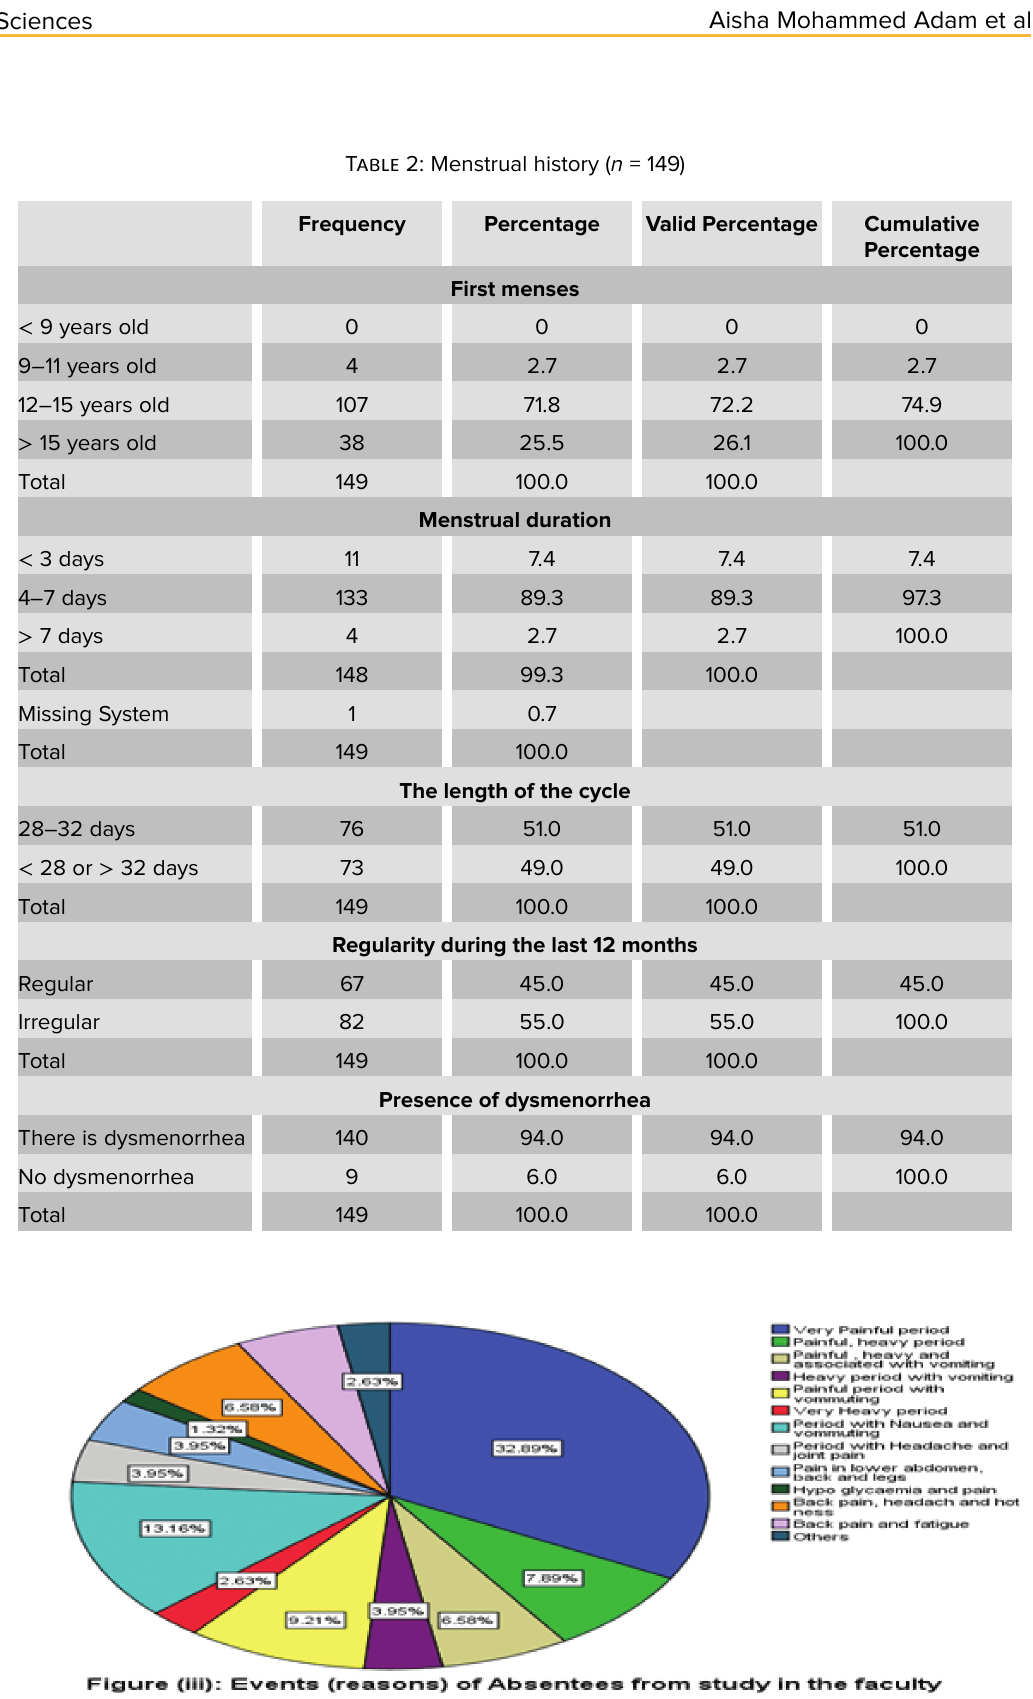
Figure 1: Reasons of absentees from study in